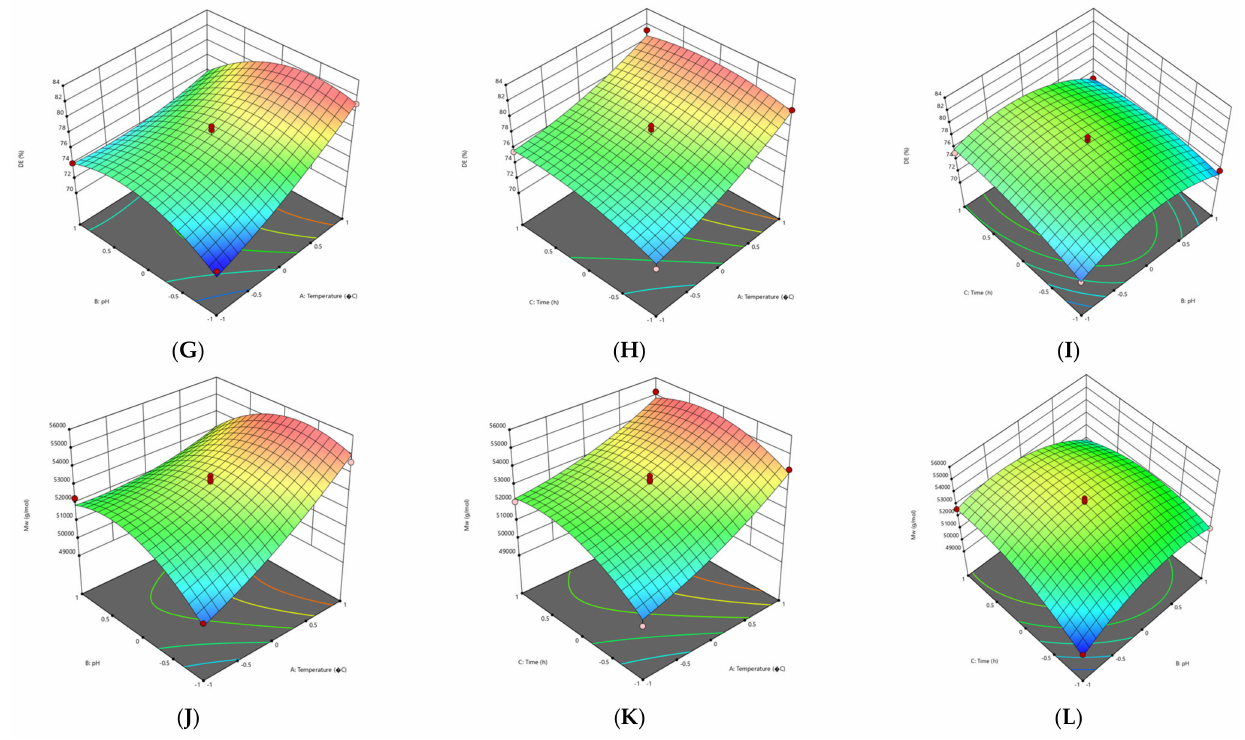
Figure 1. 3D graphs showing the influence of extraction parameters on the yield ( A – C ), GalA content